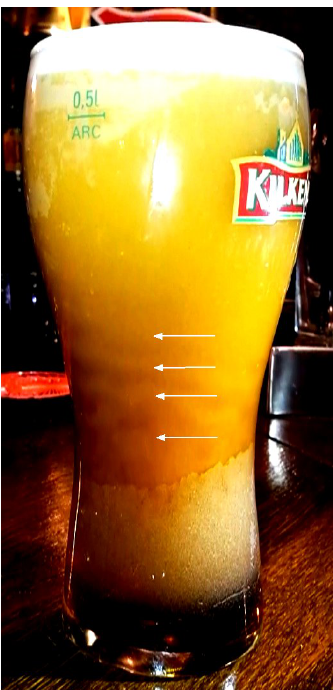
Figure 2. Waves in a freshly served pint of a stout beer. The arrows mark the location of the peaks in bubble concentration. The downward motion of the waves can be observed in the associated Video S3 (see Supplemental Materials). Note also the chaotic oscillation of the front that separates the recirculation bubble trapped by the thickening of the glass near the bottom and the downwards flow of foam near the